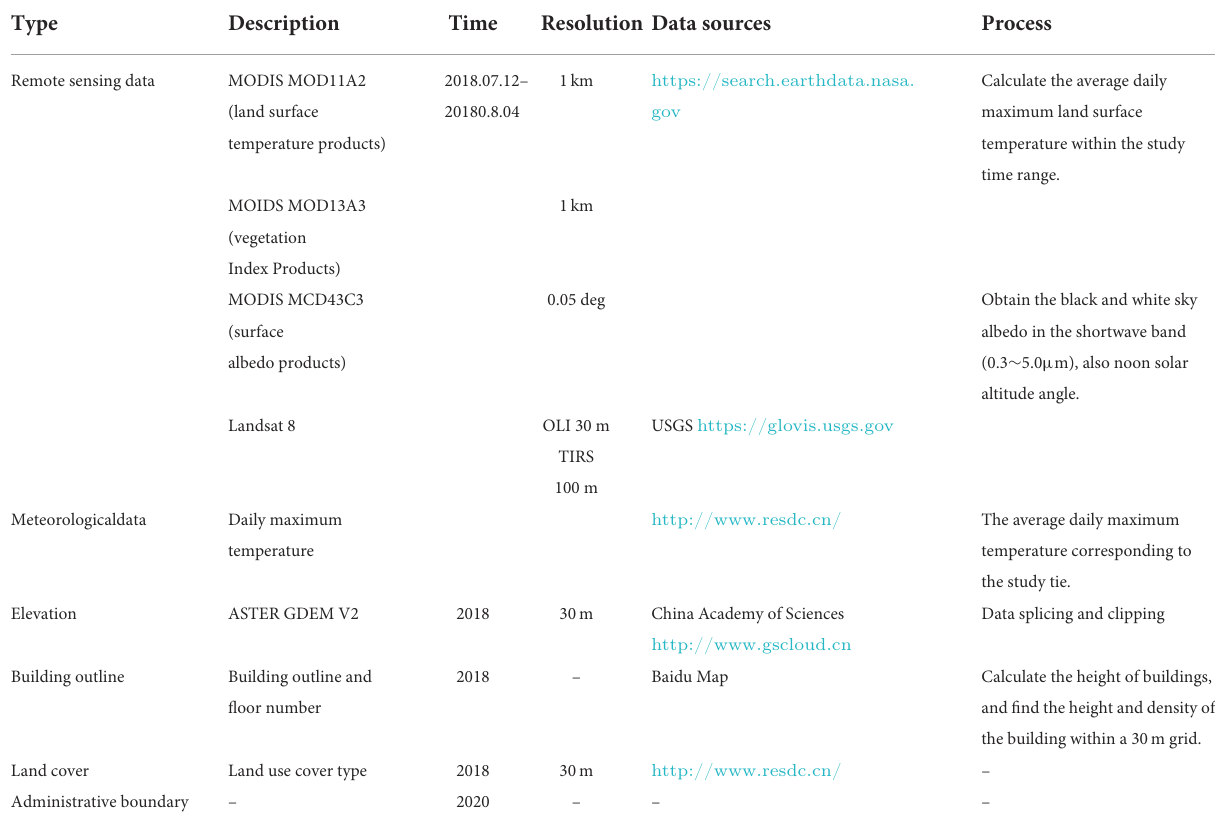
TABLE 1 Data sources and